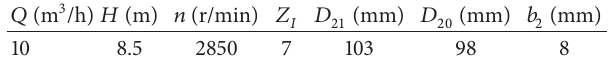
Table 1: Design parameters of impeller.